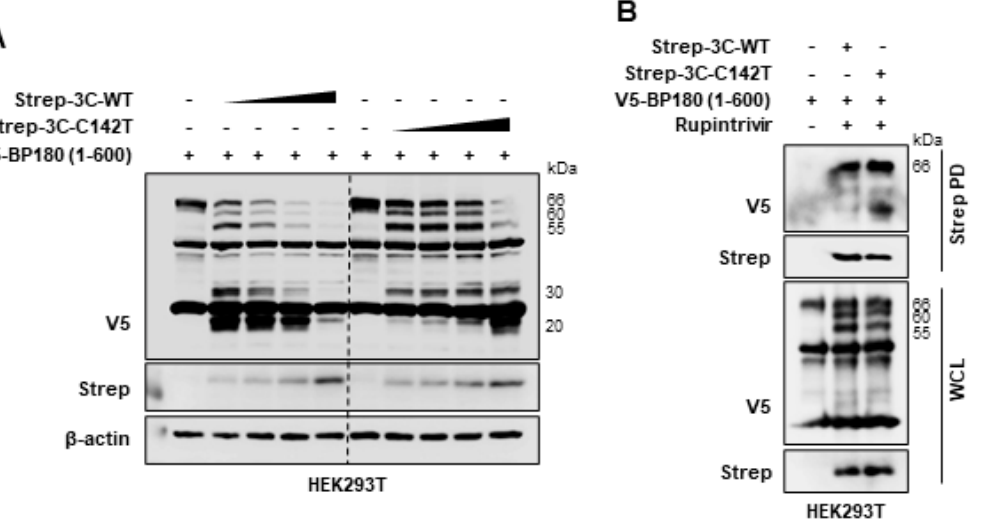
Figure 3. FMDV 3C pro interacts with BP180: ( A ) HEK293T cells were transiently transfected with Strep–tagged wild–type FMDV 3C pro or 3C pro C142T plasmids in a dose–dependent manner (10, 20,